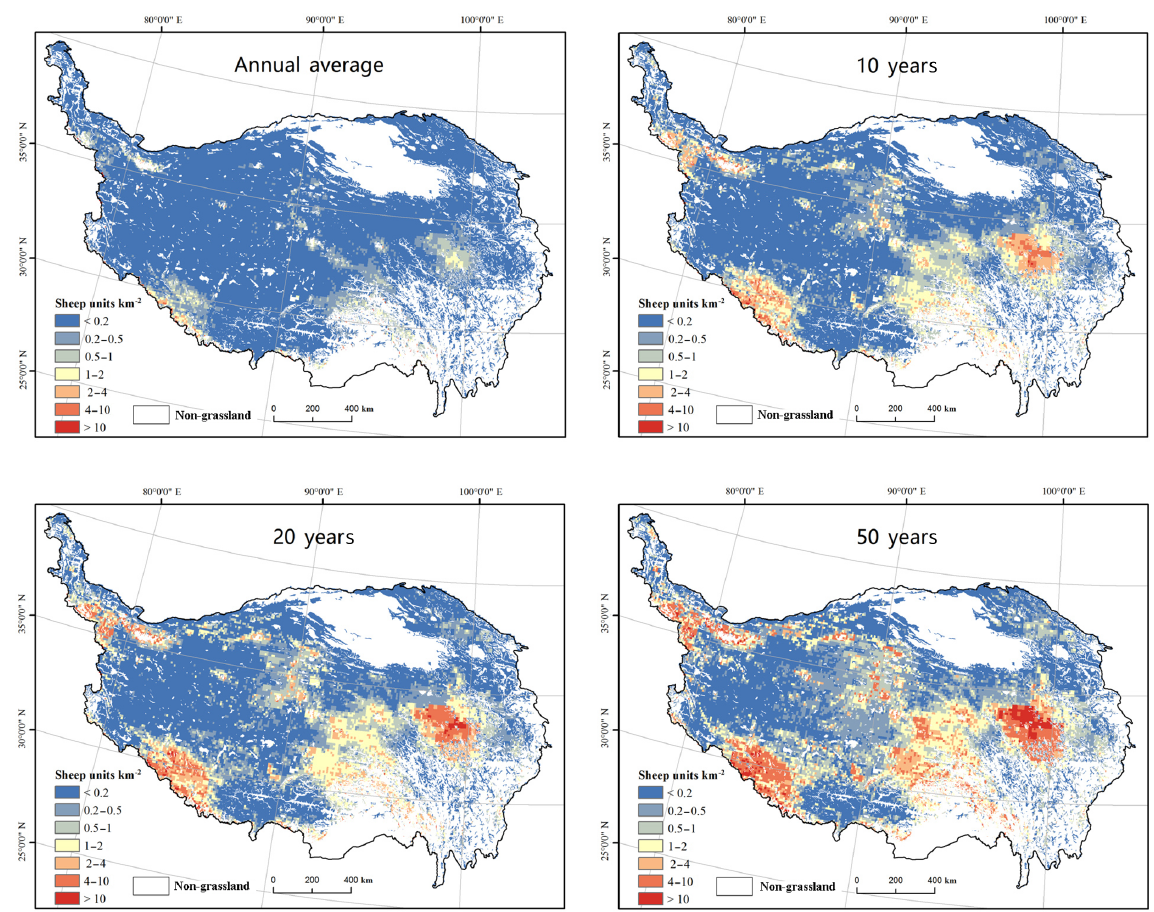
Figure 8. Gridded livestock snow disaster risk in terms of mortality (sheep units km − 2 ) in annual-average values, and 10-, 20-, and 50-year return-period values.The grid size is 0.1 ◦ × 0.1 ◦